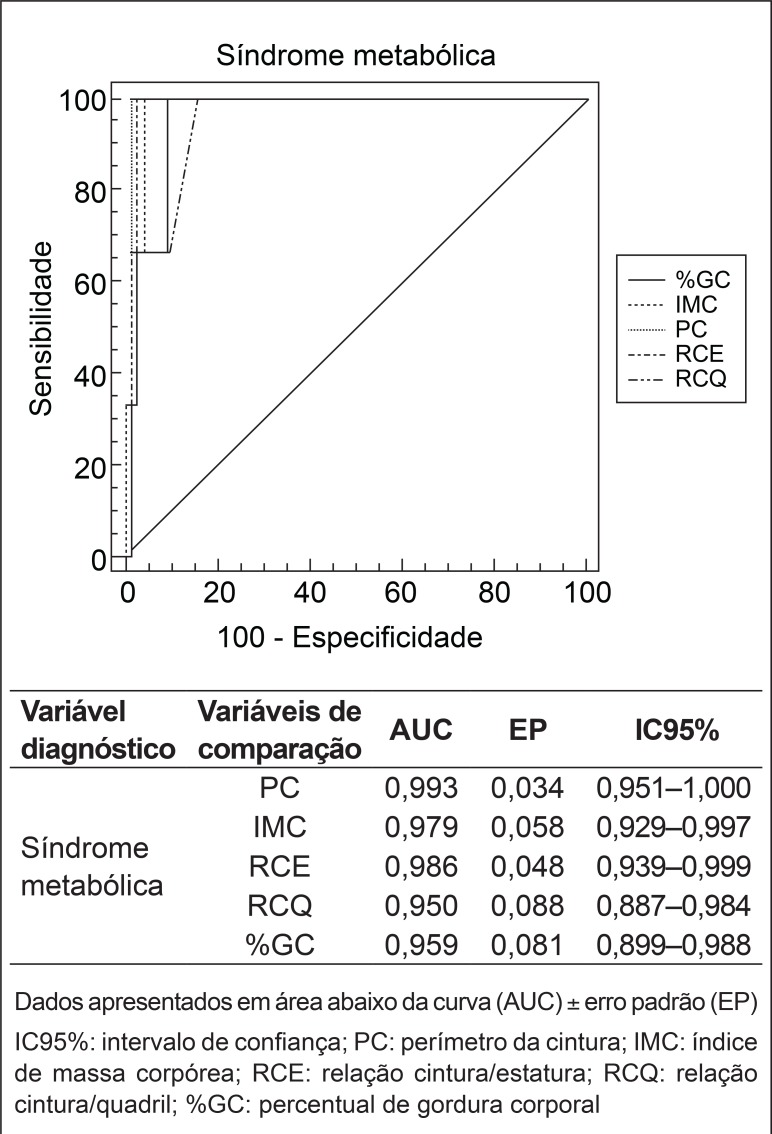
Resultados da curva ROC comparando variáveis antropométricas e de
composição corporal enquanto discriminadores da síndrome metabólica em
adolescentes do sexo feminino